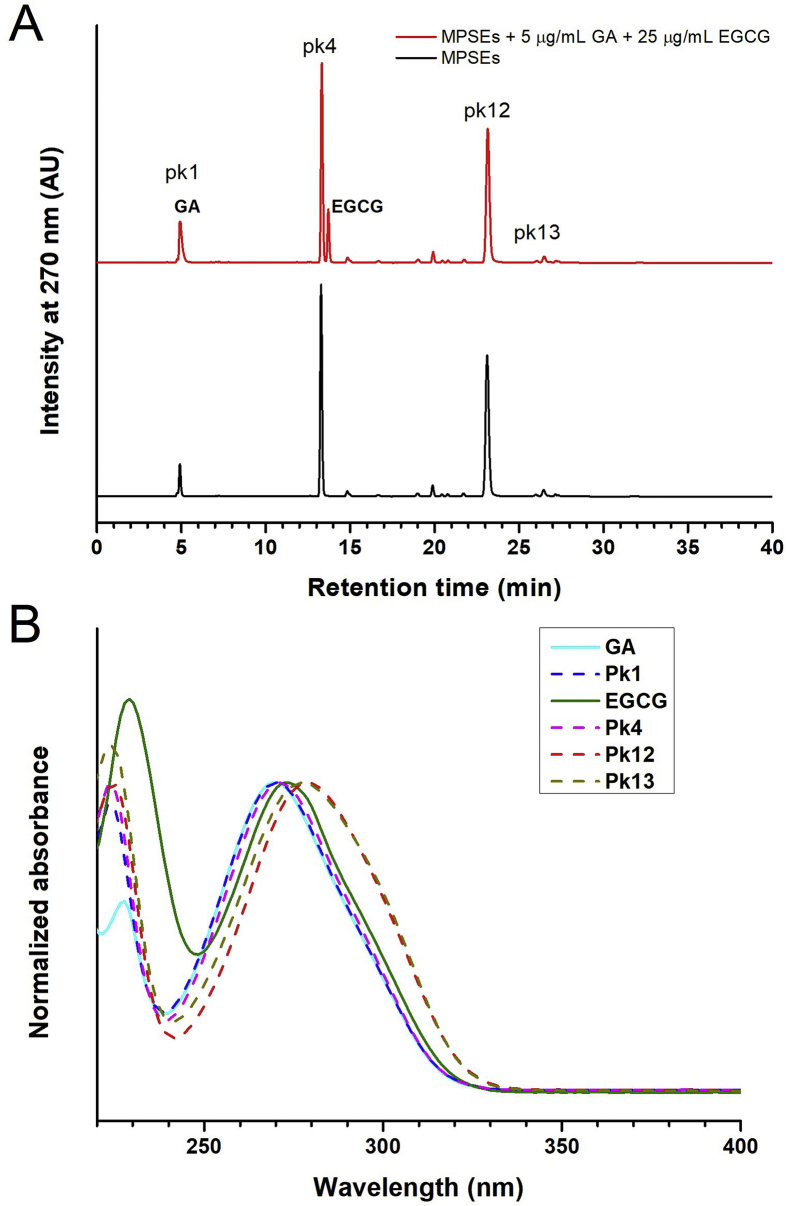
(A) HPLC chromatogram of only green maprang with the addition of standard GA and EGCG (B) UV-Vis spectral analysis of 4 major peaks of the maprang seed extracts.